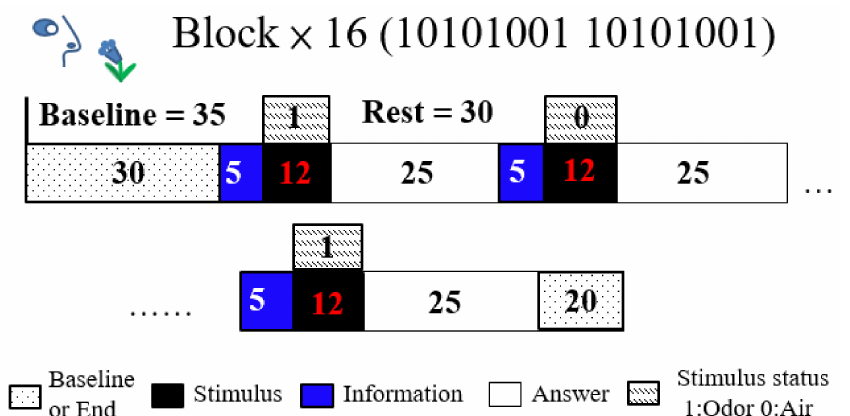
Figure 2. Schematic representation of the experimental paradigm: A block comprising a 12 s stimulus and a 30 s rest period, along with a 35 s baseline and 20 s termination period.